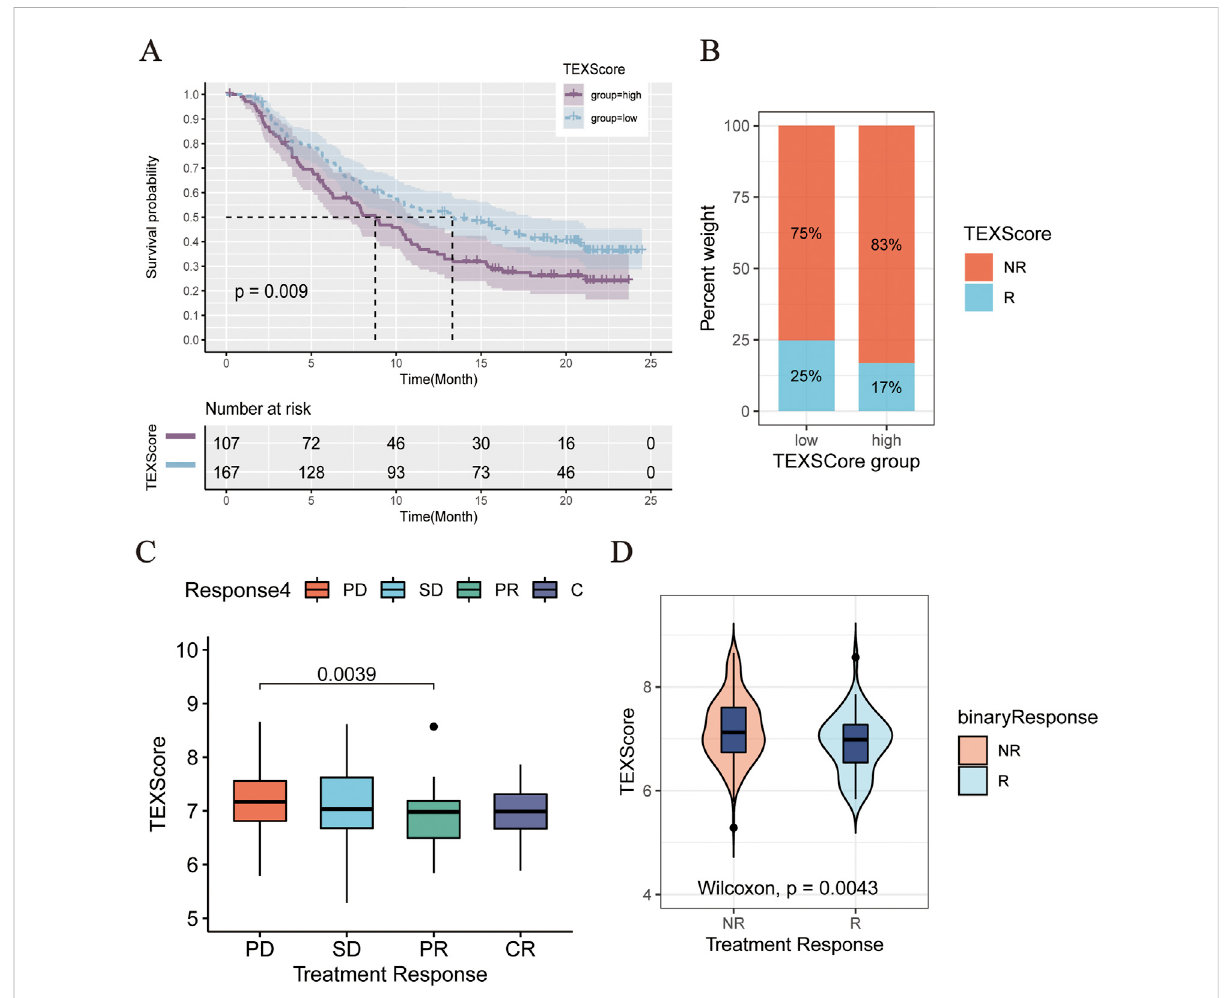
FIGURE 7 (A) Comparison of clinical outcomes between high and low TEXScore patients. (B) Bar chart showed the effectiveness of immunotherapy in patients with high and low TEXScore. (C,D) TEXScore corresponding to the clinical response of patients to